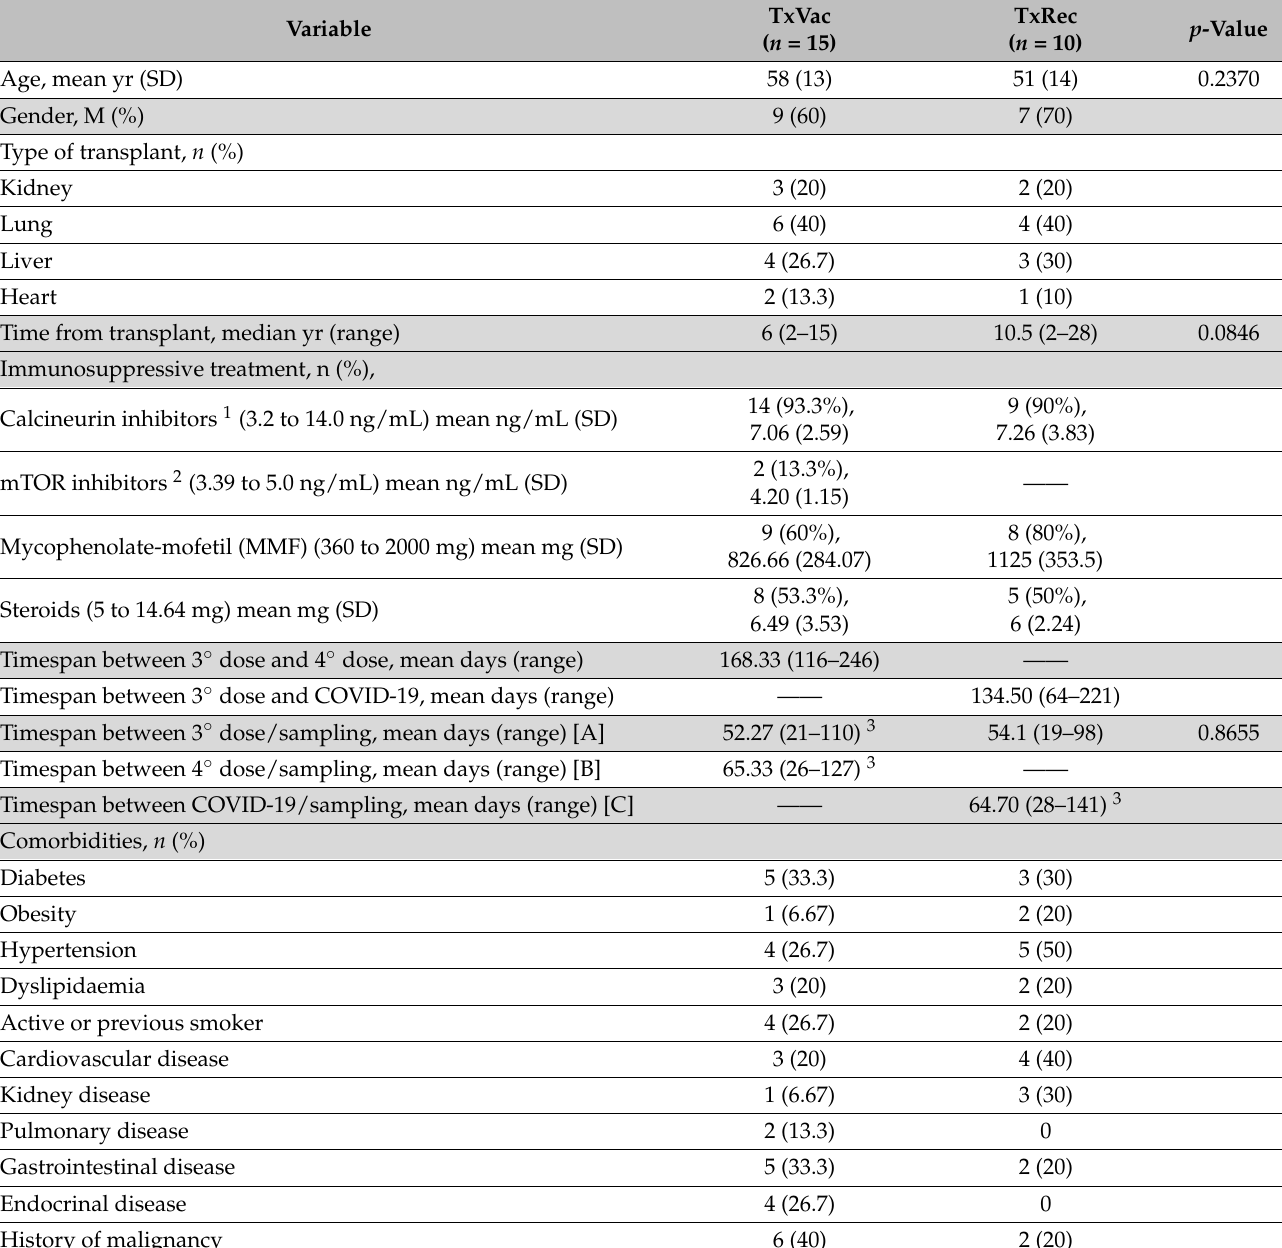
Table 1. Baseline characteristics of SOTRs. 1 tacrolimus; 2 everolimus; 3 p -value of [A], [B], and [C] from all patients was not significant ( p -value between A and B = 0.253, between A and C = 0.303, and between B and C = 0.962). Welch’s t -test was used for statistical analyses, and p < 0.05 was considered statistically significant. Abbreviations: yr, year; SD, standard deviation; M, male; n, number; MMF, mycophenolate